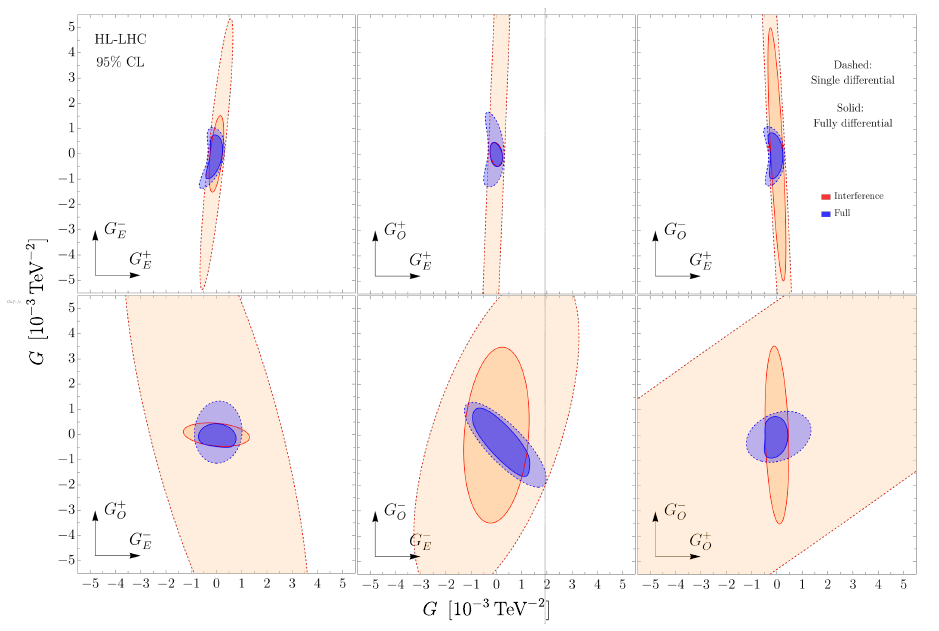
Figure 4 . Allowed regions at 95% CL on the six coordinate planes along the four G ± Solid contours correspond to the fully-differential analysis, while the dashed ones are obtained with the single-differential measurements. The blue shaded regions include the full dependence on the Wilson coefficients in the cross-section, while only the linear terms are retained in the orange shaded